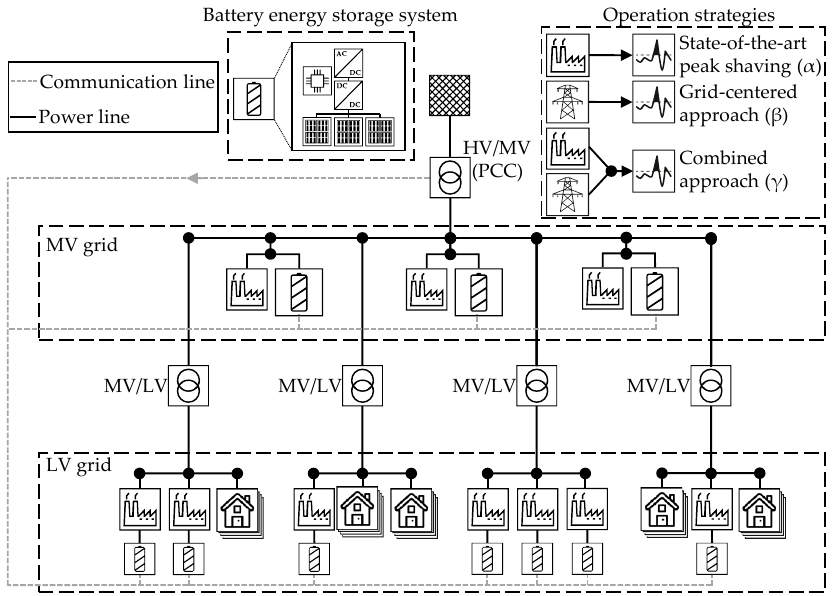
Figure 1. Graphical overview of the simulated grid and battery energy storage systems (BESSs), as well as the investigated operation strategies. The BESS, modeled in detail, located at various nodes in a test grid, is operated in three different operation strategies to reduce the local peak load (Strategy α ) or the peak load at the point of common coupling ( β ) or both ( γ